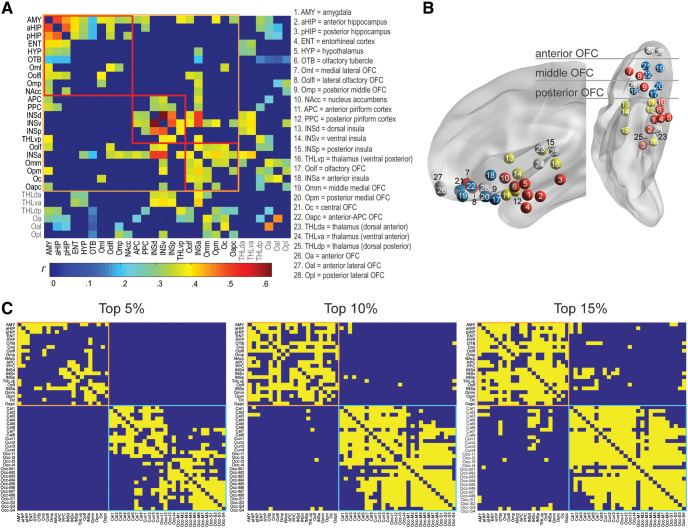
The olfactory network. A, A weighted sparse 28 × 28 correlation matrix of group average Pearson’s rs for all suprathreshold pairs. ROIs included in the olfactory network are enclosed in the orange box, with the three identified modules (subnetworks) enclosed in the red boxes. The table lists the region names in correspondence to the ROI/node numbers. B, A transparent brain model (in sagittal and axial views) with ROIs (nodes) for the three modules coded in three respective colors. Gray nodes are ROIs not accepted into the olfactory network. C, A binary connectivity matrix reveals suprathreshold connections (shown in yellow) across the olfactory network nodes (22 parcels, enclosed in the orange box) and occipital visual cortical regions (28 parcels, enclosed in the cyan box) at three cutoff levels (top 5%, 10%, and 15%). The visual regions (Cal = calcarine gyrus; Cun = cuneus gyrus; Occ-I = occipital inferior gyrus; Occ-M = occipital middle gyrus; Occ-S = occipital superior gyrus) were strongly interconnected and relatively disconnected from the olfactory nodes.